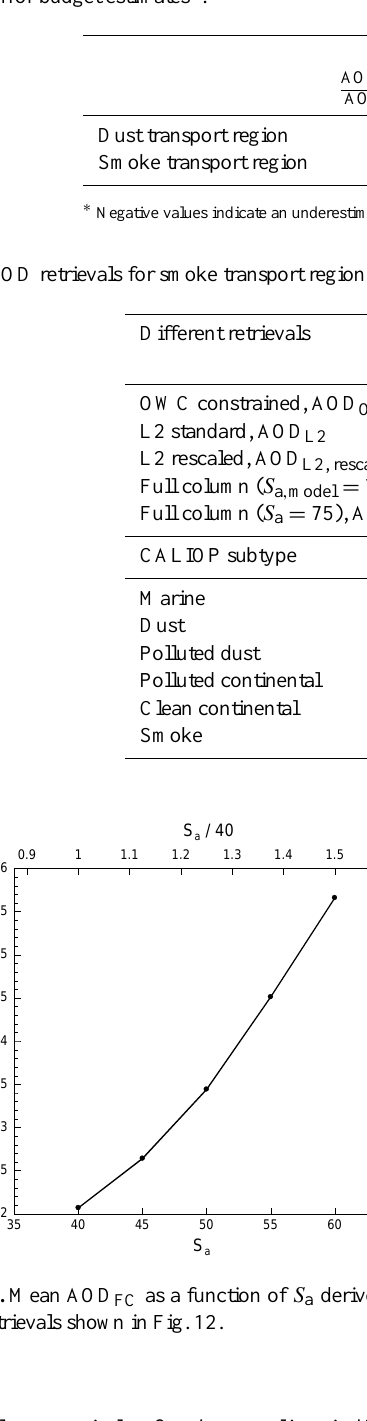
Table 2. Error budget estimates ∗ .